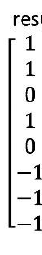
Figure 3. The difference bitmap between content bitmaps of node v and j .